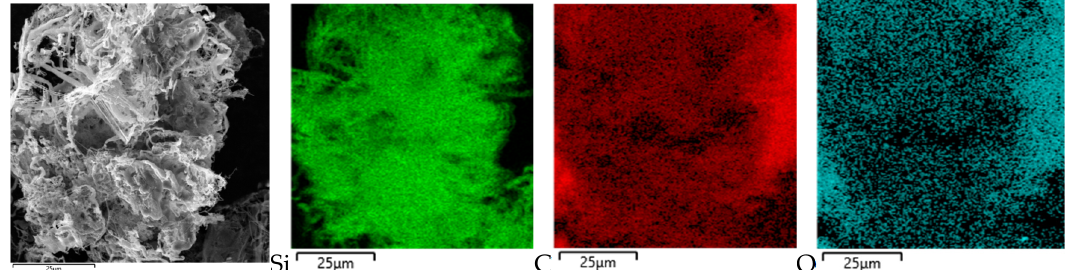
Figure 3. SEM-images and elements distribution in a SiC sample after carbothermal synthesis, oxidation of unreacted graphite, and treatment in HF solution.